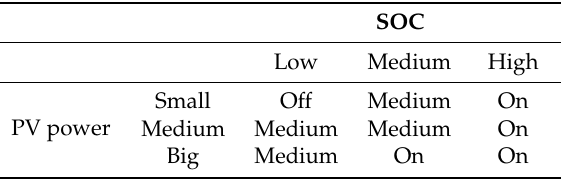
Table 2. Fuzzy rules of FLC-BAT.